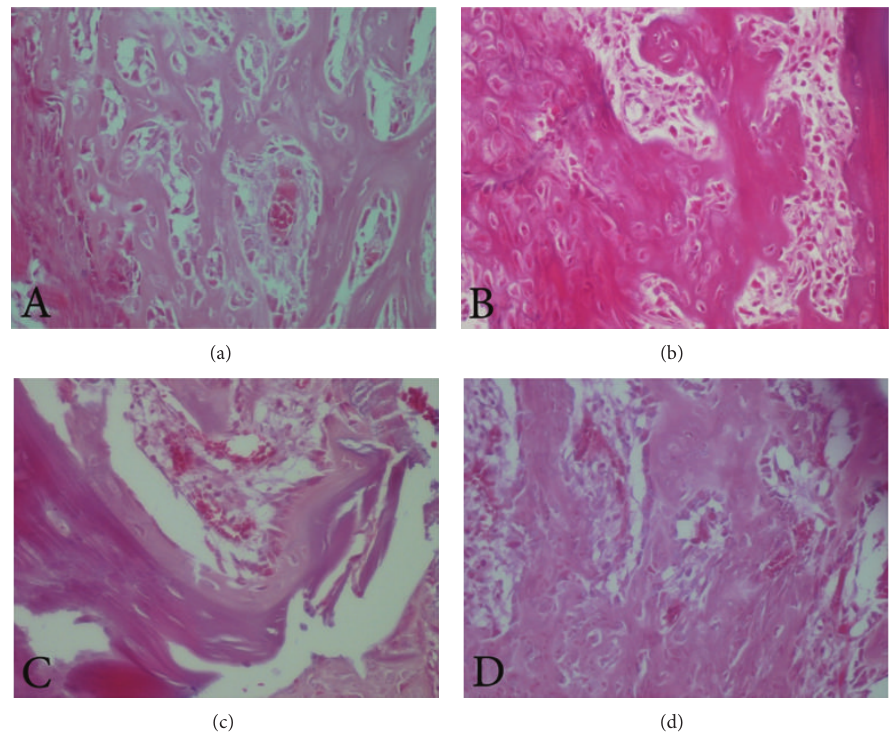
Figure 4: (a, b) Bone trabeculae on left and right tibias and (c, d) inflammation on left and right tibias on day 7.